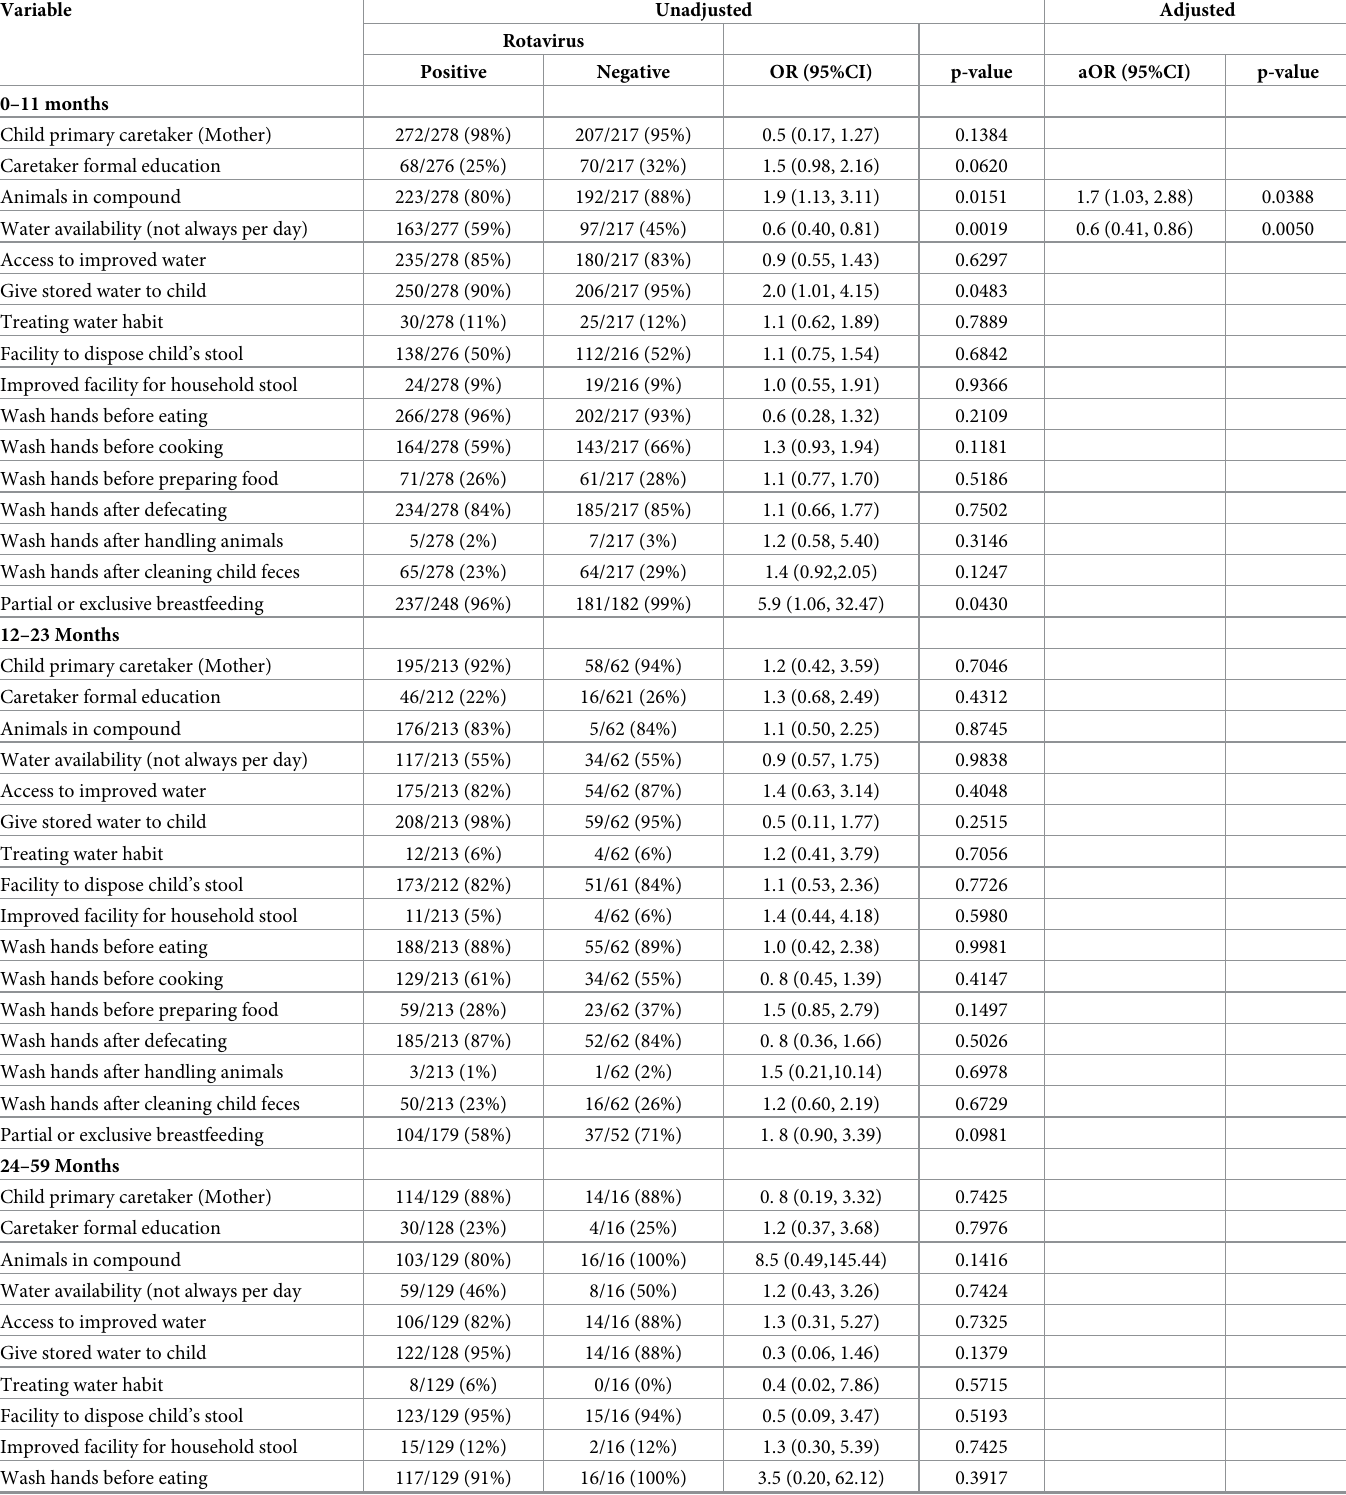
Table 5. Socio-demographic factors associated with rotavirus infections among children 0–59 months of age with moderate-to-severe diarrhea.